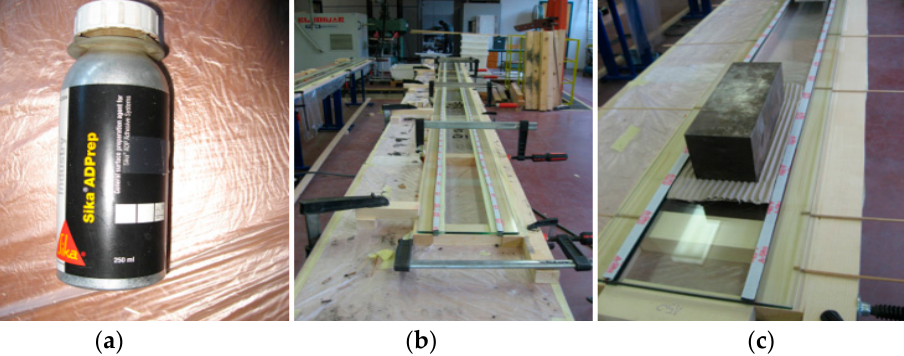
Figure 9. ( a ) Sika ADPrep Cleaner; ( b ) preparation of both materials for bonding by setting the prescribed distances; ( c ) use of spacers to maintain the intended adhesive thickness.